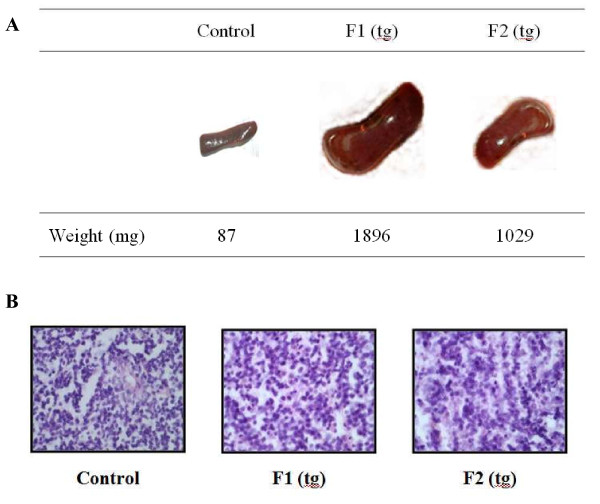
Morphological changes and histological analysis of the spleen in splenomegaly. A. Distinct splenomegaly-related changes were observed in the transgenic mice. The spleen weights of the transgenic mice were remarkably higher (21-fold increase in F1 and 11-fold increase in F2) than those of the control mice. B. Histological analysis of the spleen of the transgenic and control mice. Paraffin sections were stained with hematoxylin & eosin (original magnification, × 400).